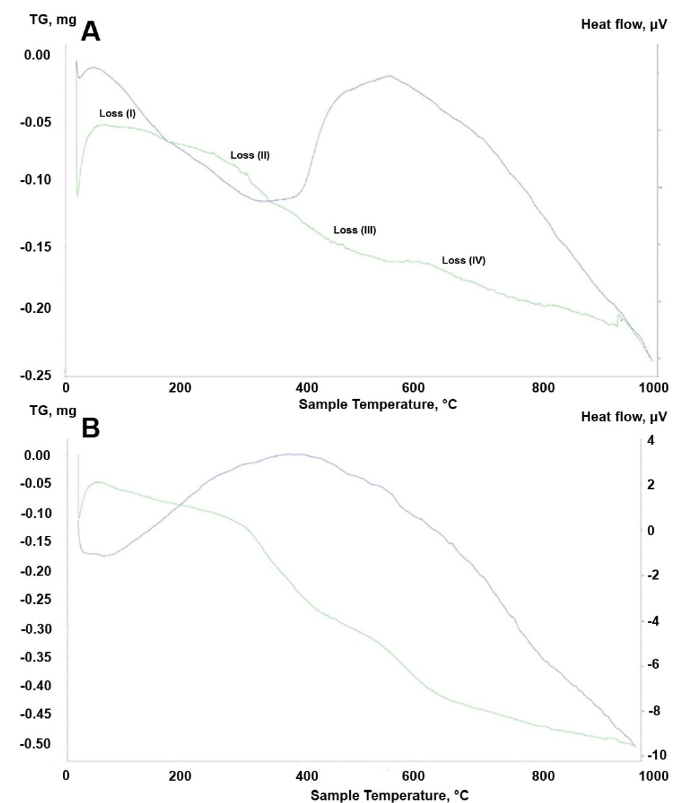
Figure 11. TGA curves of ( A ) ZrO 2 _0 and ( B ) Al 2 O 3 _0.